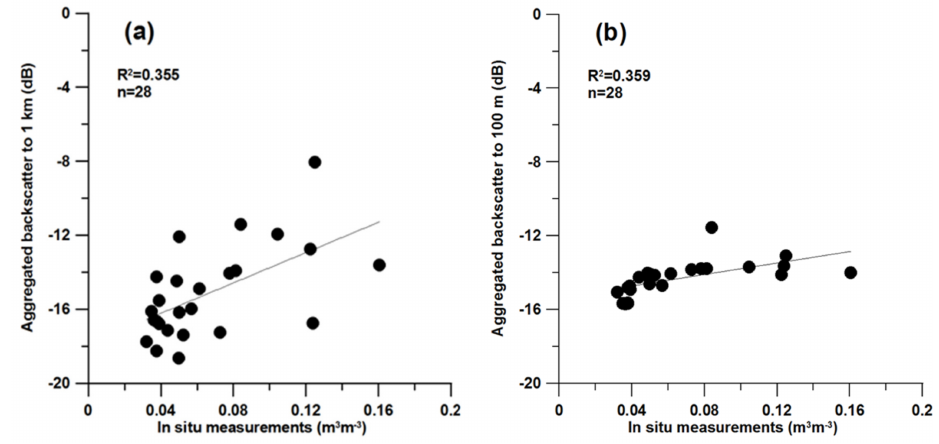
Figure 4. Thebackscatteraggregatedto( a )1kmandto( b